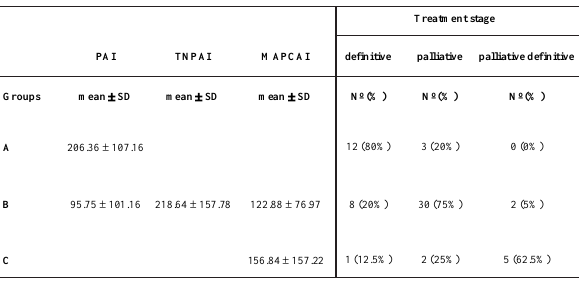
Table 4. Correlation between the A, B and C groups, their indices and treatment